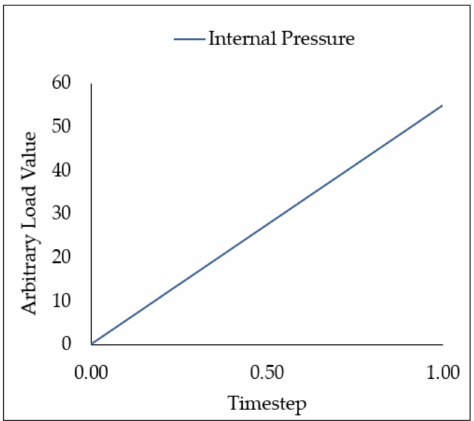
Figure 4. Application of internal pressure during FEA.